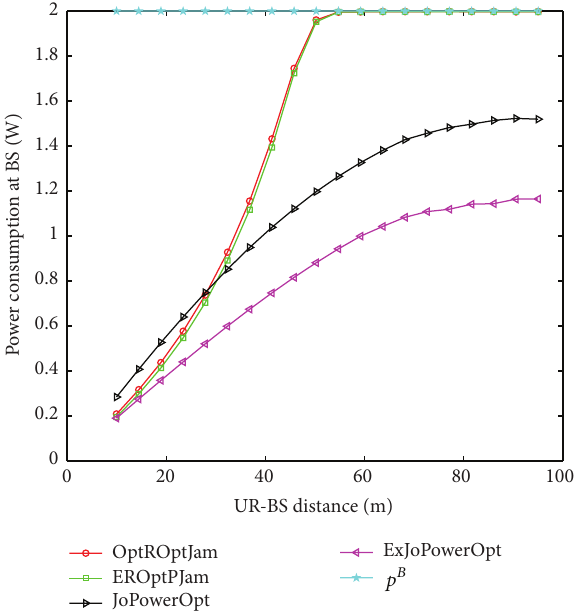
Figure 6: Total power consumption at BS versus UR-BS distance.